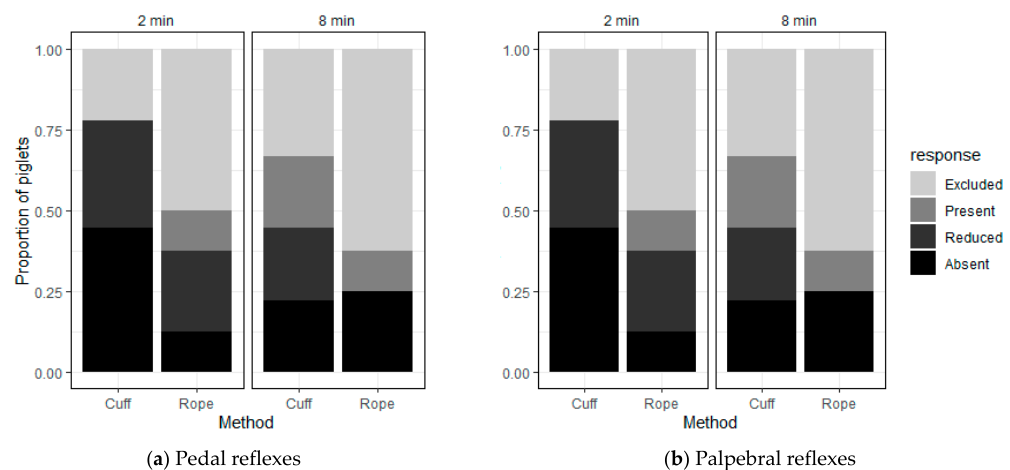
Figure 7. Number of piglets exhibiting each level of ( a ) Pedal reflex responses and ( b ) Palpebral reflex responses at 2 and 8 min after application of the thoracic squeeze for each method of application. ‘Excluded’ refers to piglets that did not have their reflexes tested because of low intensity arousals that preceded a discontinuation of the squeeze soon after the testing point or because the squeeze had already been discontinued. ‘Present’ refers to a full limb withdrawal or blink of the eye; ‘Reduced’ refers to a slight limb withdrawal or twitch of the eye; ‘Absent’ refers to no limb or eye responses to reflex testing.